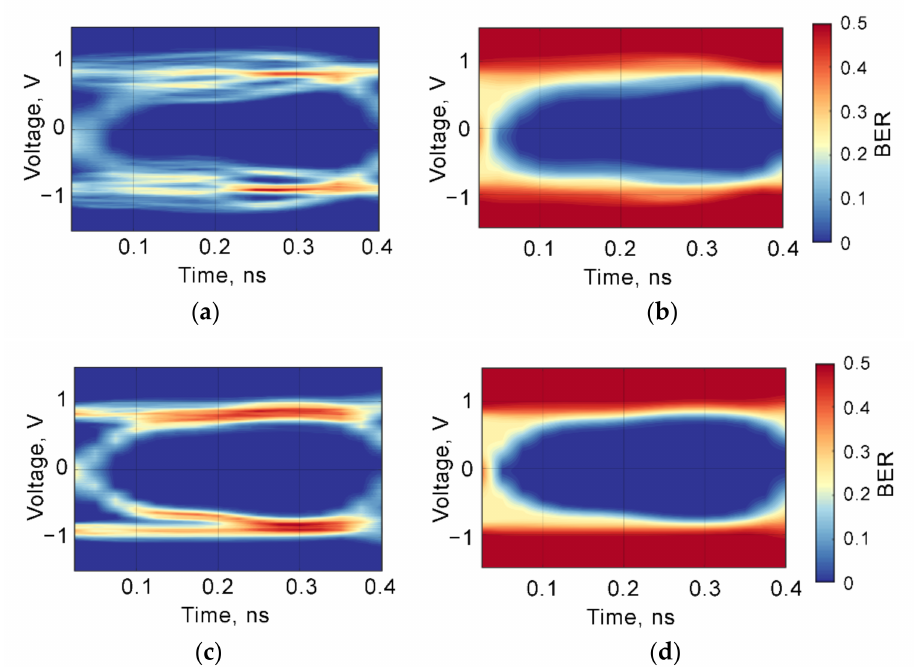
Figure 14. ( a ) Eye diagram of victim signal with crosstalk; ( b ) BER diagram of victim signal with crosstalk; ( c ) eye diagram of estimated signal; ( d ) BER diagram of estimated signal. Bit rate is 2.5